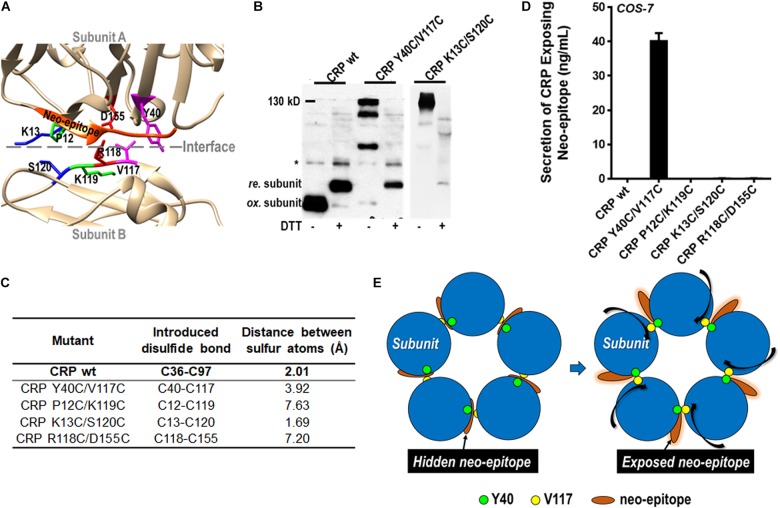
The pentameric assembly of CRP is adjustable. (A) The four residue pairs that were mutated to introduce inter-subunit disulfide bond are indicated with different color. The a.a. 199–206 neo-epitope is colored with orange. CRP wildtype (wt) or mutants with a signal peptide of its own were expressed in COS-7 cells. (B) CRP secreted into conditioned media was examined by immunoblotting with 3H12 mAb (*non-specific signal). Mutants K13C/S120C and Y40C/V117C could be normally secreted as pentamer with inter-subunit disulfide bonds (∼130 kD). (C) The distances between the introduced cysteine residue pairs. (D) The neo-epitope exposure in secreted CRP was determined by ELISA with 3H12 mAb. The neo-epitope was exposed in Y40C/V117C, but not in K13C/S120C. (E) Proposed model of CRP activation by rotating subunits while maintaining the pentameric assembly.